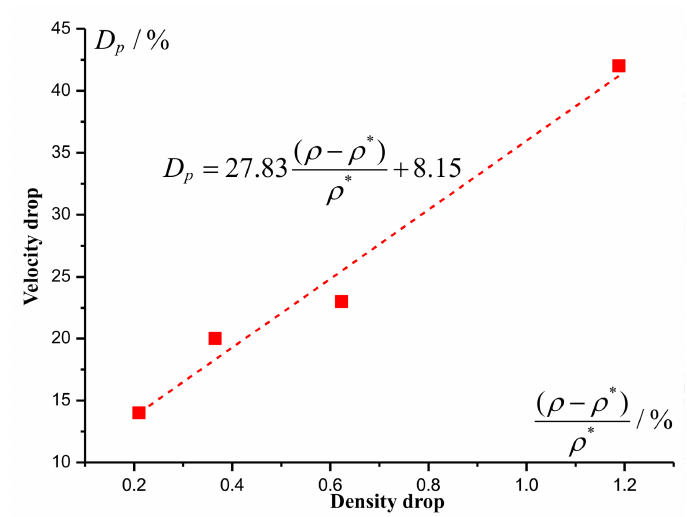
Figure 12. Relationship between velocity drop and density